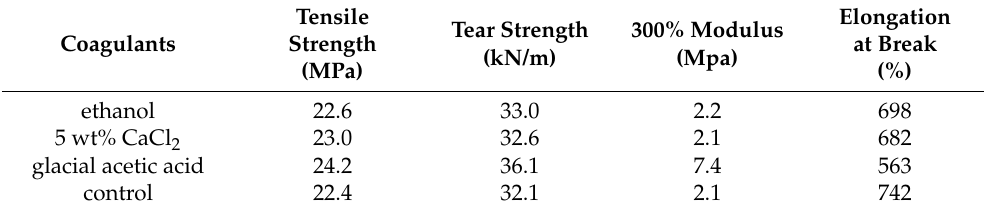
Table 2. Effect of different RC particles on the mechanical properties of RC/NR